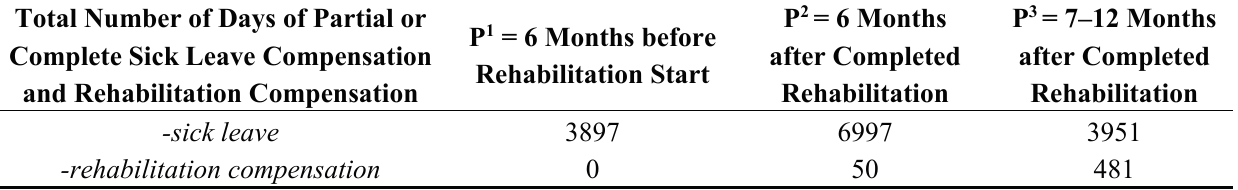
Table 7. The total number of days with sickness and rehabilitation compensation (partial or full) for participants in the OHS group ( n = 45) during P1 1 , P2 2 , and P3 3 . Total Number of Days of Partial